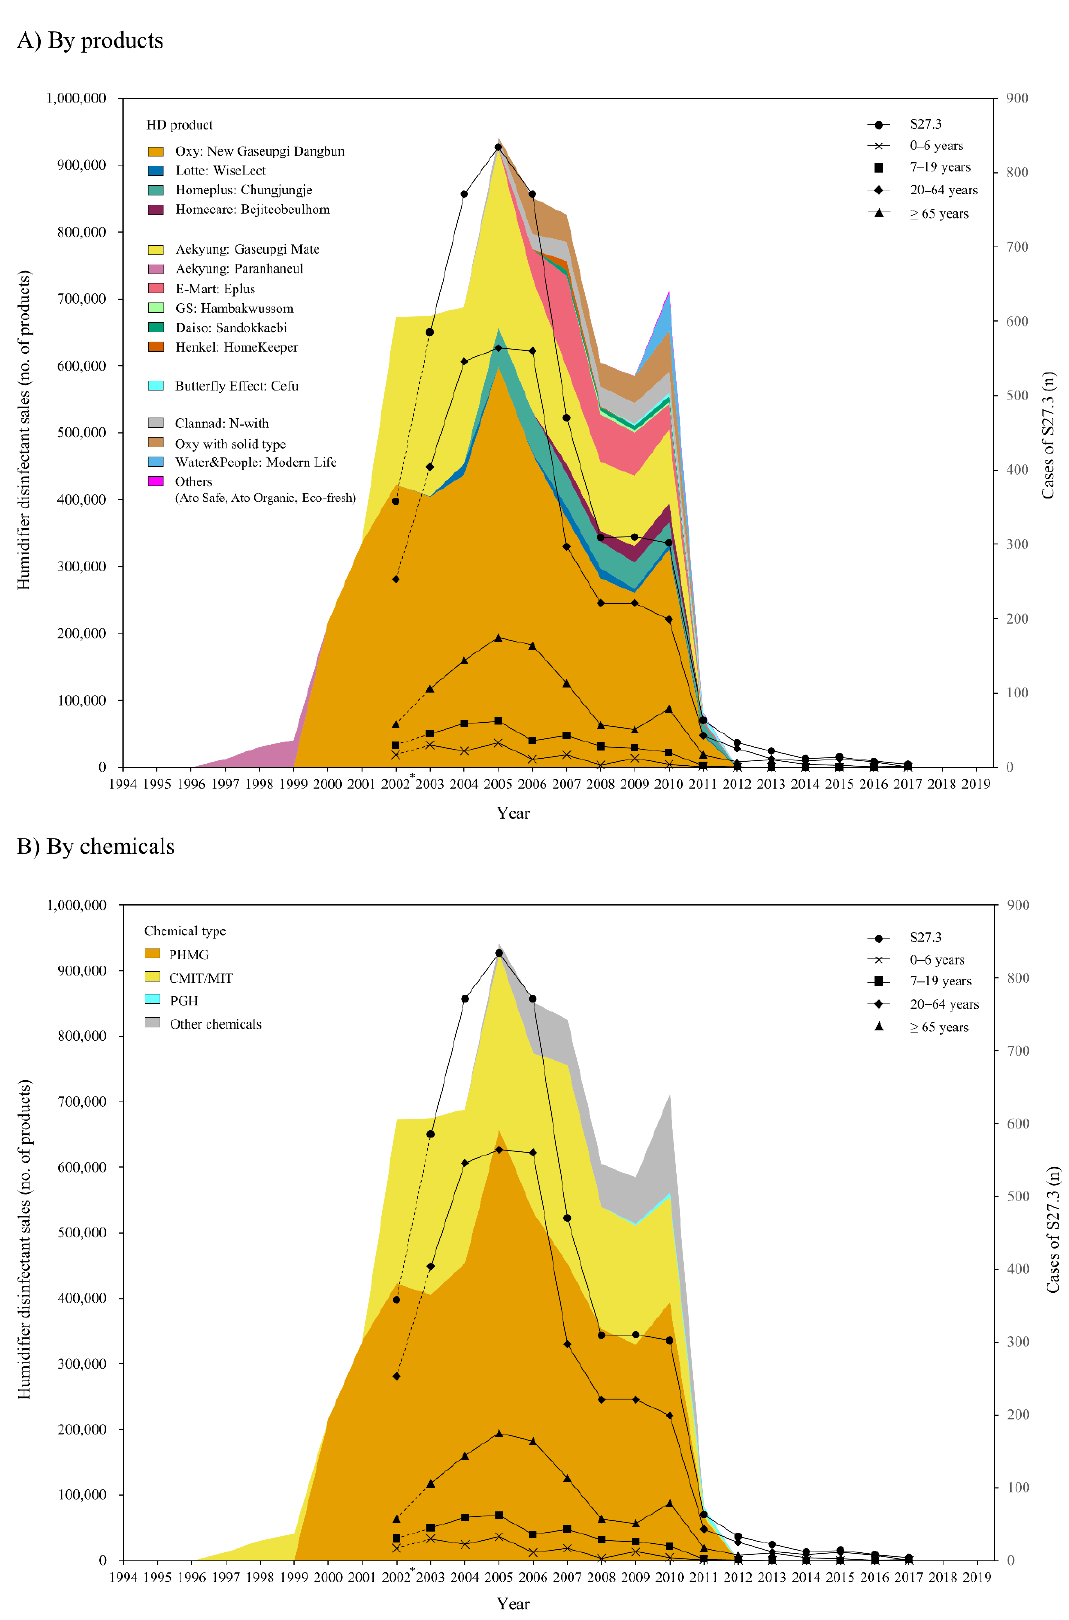
Figure 1. Annual sales of humidifier disinfectants and NHIS-recorded cases of S27.3. * Cases in 2002 may include pre-existing cases and are indicated as dotted lines.